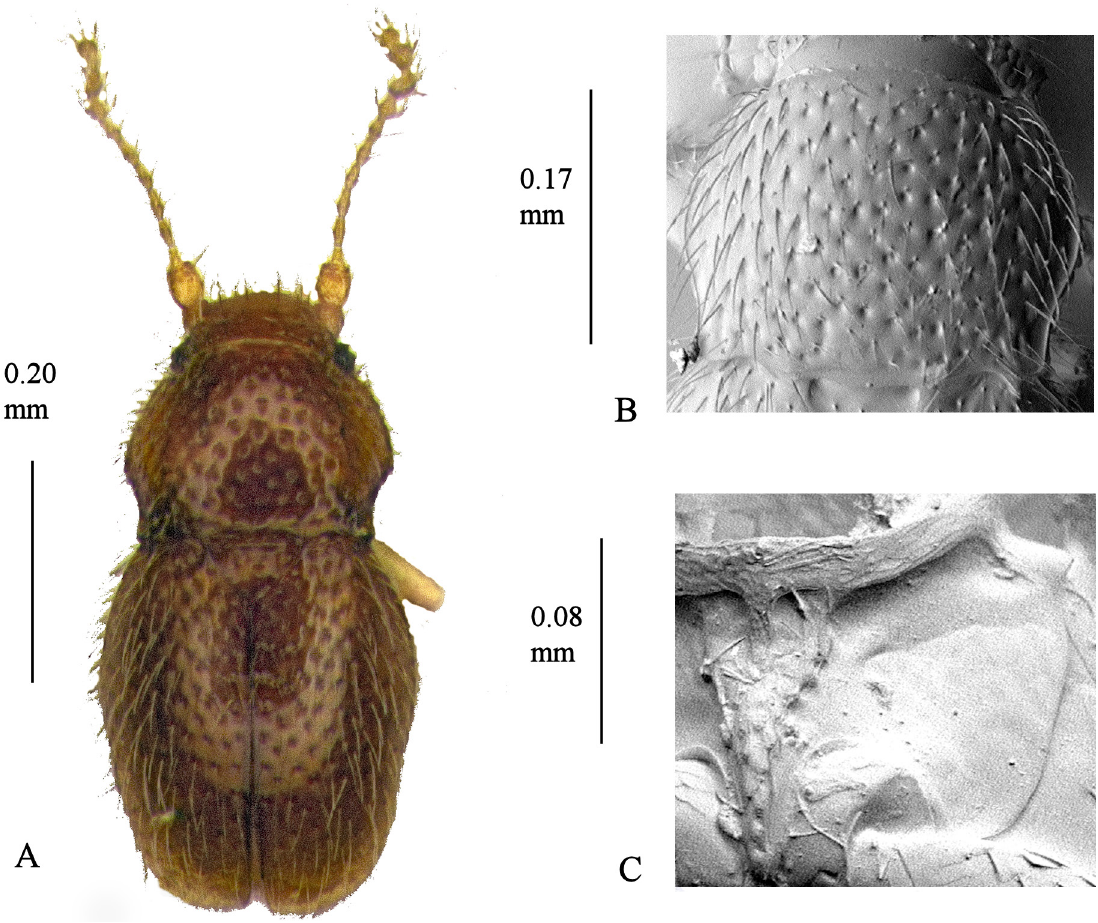
Fig. 58 . Cissidium nomurai Sawada, 2008. A . Habitus. B . Pronotum, × 600. C . Mesoventrite showing median extension of collar, mid-keel, keel and lateral margin,